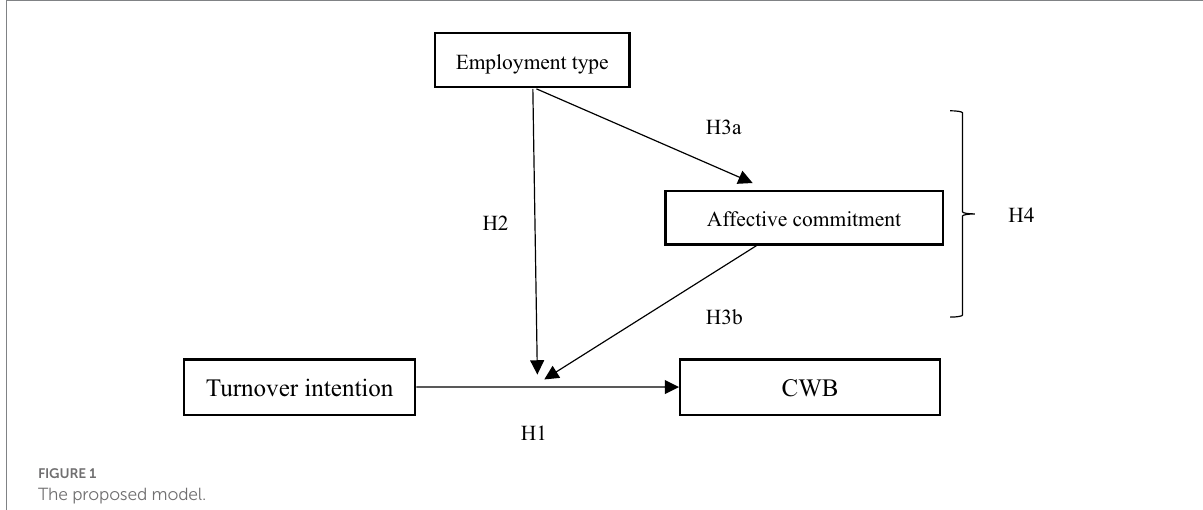
FIGURE 1 The proposed model.